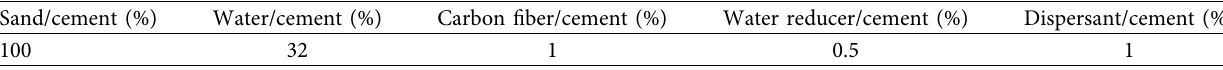
Table 3: Mass ratio of CFRC materials.